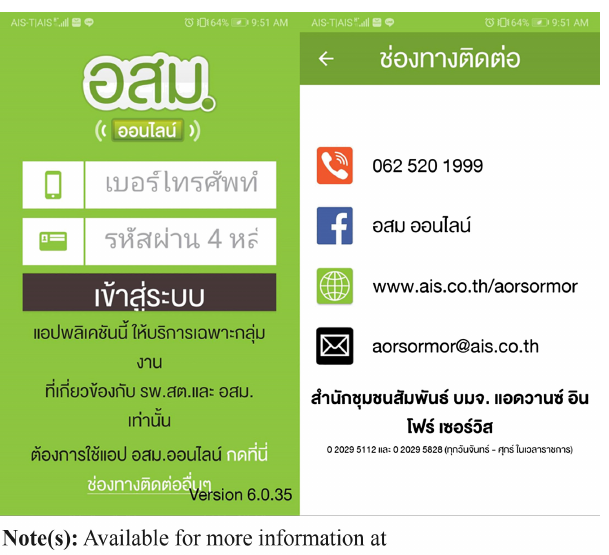
Figure 2. A screenshot of Aor Sor Mor Online on mobile